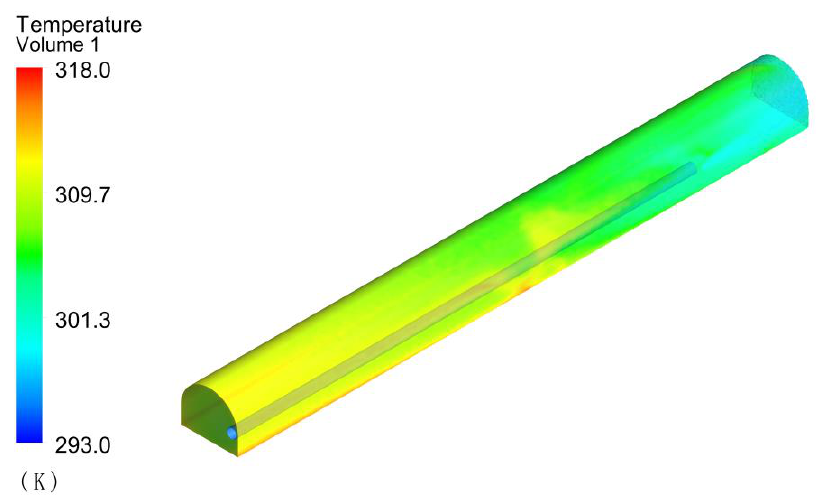
Figure 10. Three-dimensional distribution of Model 3 roadway temperature.